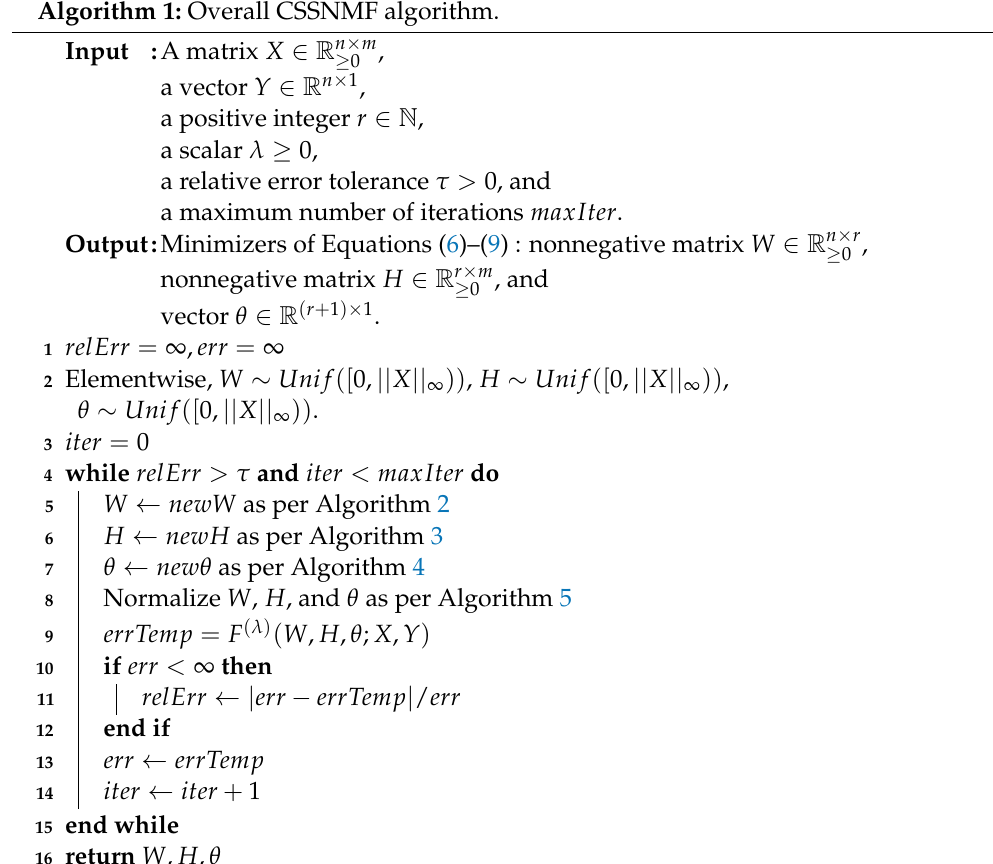
Algorithm 1: Overall CSSNMF